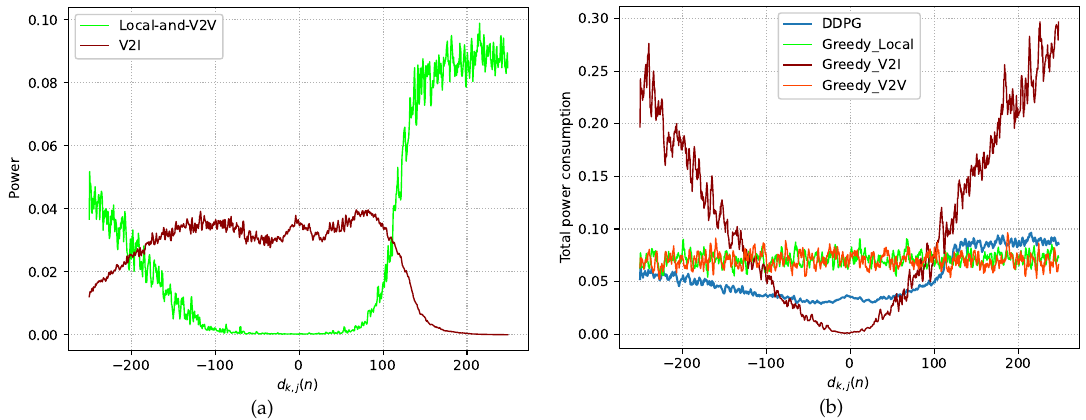
Figure 4. Power. ( a ) DDPG power allocation. ( b ) Total power consumption.